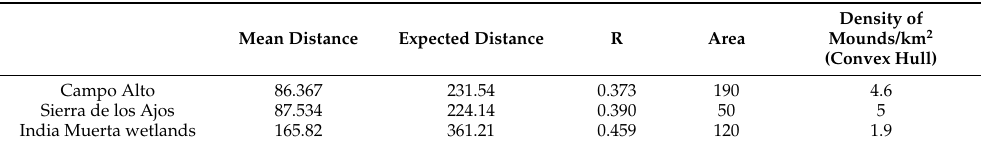
Table 2. Results of the nearest neighbor analysis for each local cluster.R abbreviation in the table represent the nearest neighbor